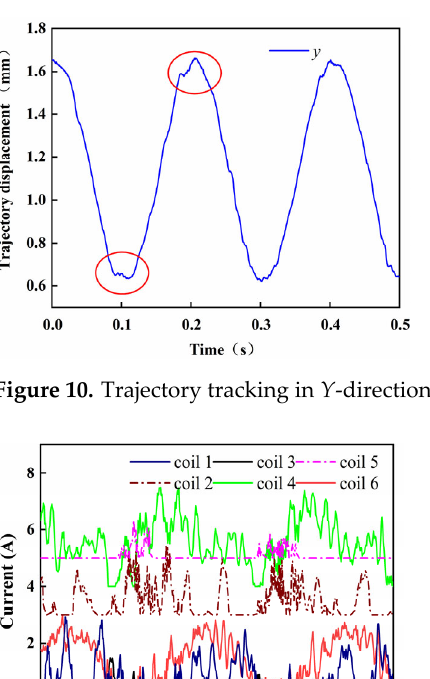
Figure 10. Trajectory tracking in Y ‐ direction under centralized control.